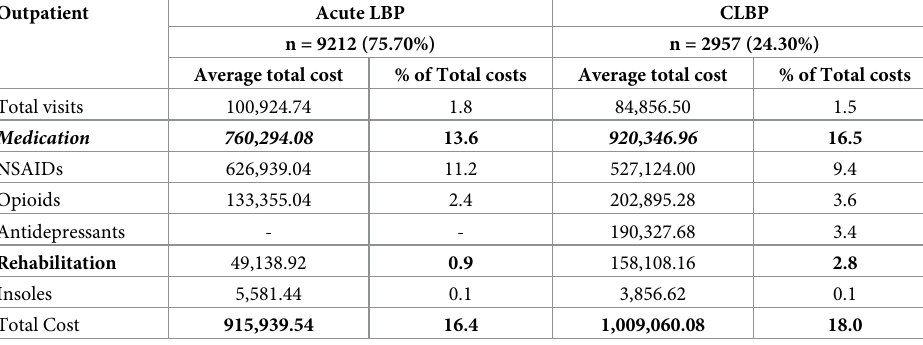
Table 5. Outpatient costs comparison between acute and chronic LBP.